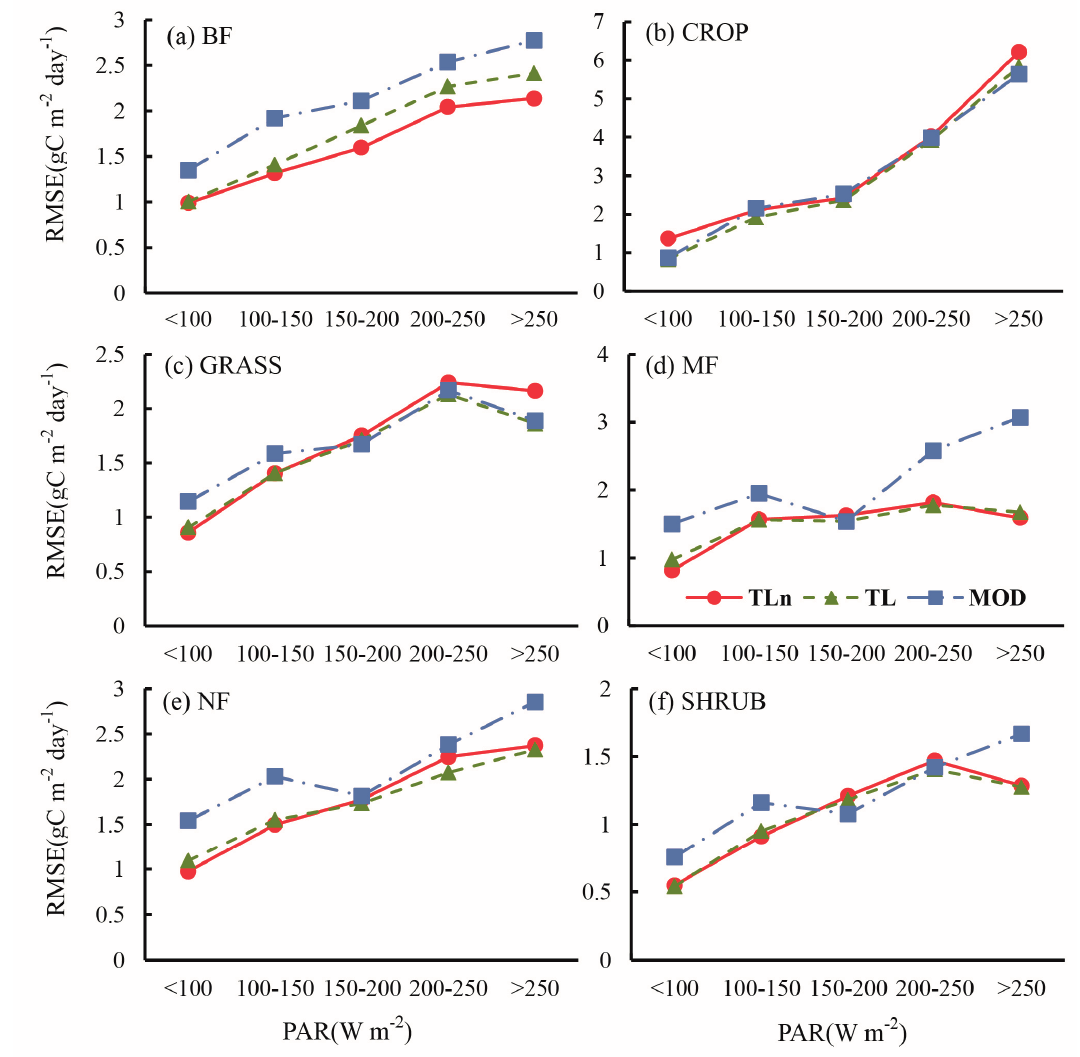
Figure 7. The RMSE of modeled GPP against tower-derived GPP within different PAR classes for 6 different vegetation types: ( a ) BF, ( b ) CROP, ( c ) GRASS, ( d ) MF, ( e ) NF and ( f ) SHRUB, at the daily